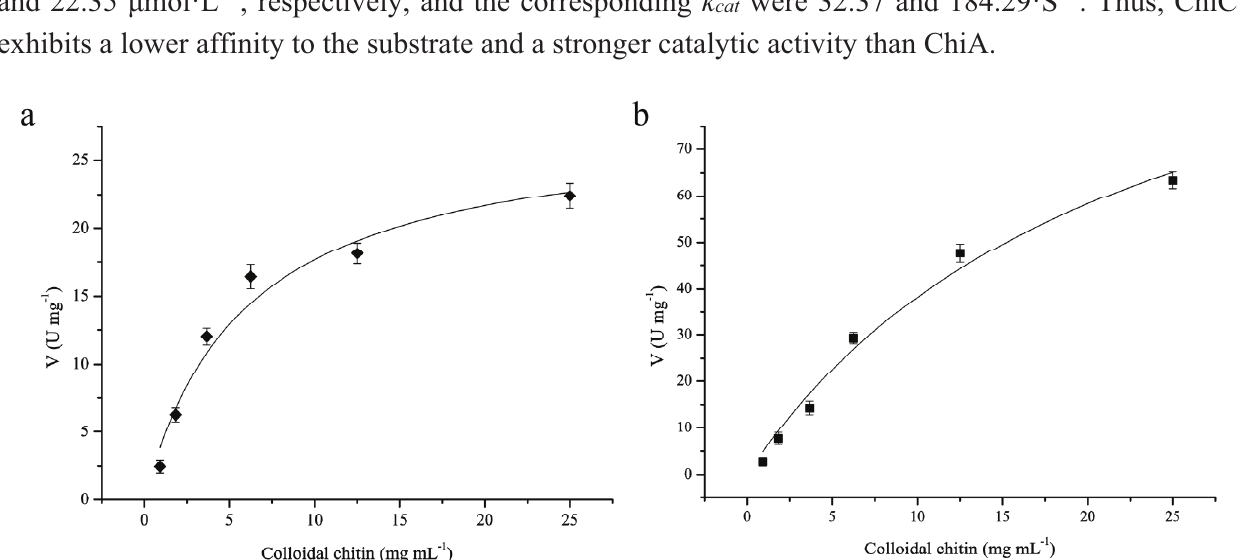
Figure 6. Michaelis-Menten plots of purified chitinases toward colloidal chitin. ( a ), Michaelis-Menten plot of ChiA; ( b ), Michaelis-Menten plot of ChiC; Kinetic